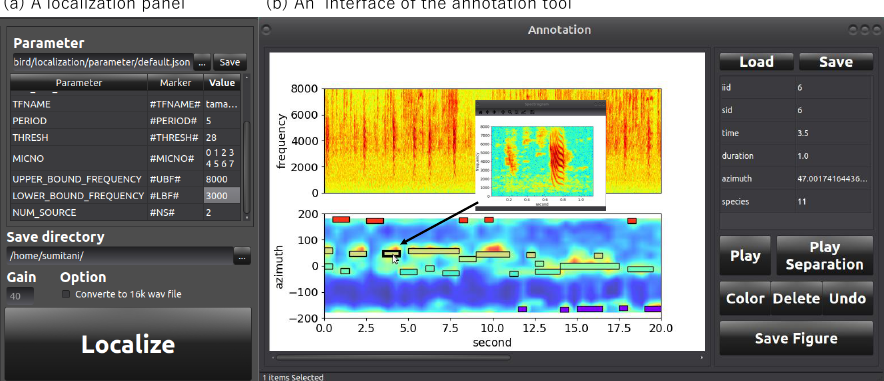
Figure 3. A GUI of HARKBird. In the localization panel ( a ), the user can set specific values of the essential parameters related to localization and separation of bird songs using HARK, which are enumerated in a list. A user can tweak these parameters This helps us to localize the target sound sources (i.e., vocalizations of ZFs) and exclude other noises or unnecessary sounds. The result of the source localization is displayed in can be checked from the annotation tool interface ( b ), where both spectrogram and MUSIC spectrum are displayed. Each colored box represents the time and DOA of a localized sound source. The length of each box indicates the duration of the localization, and the spectrogram of each separated sound pops up and can be replayed by clicking the corresponding